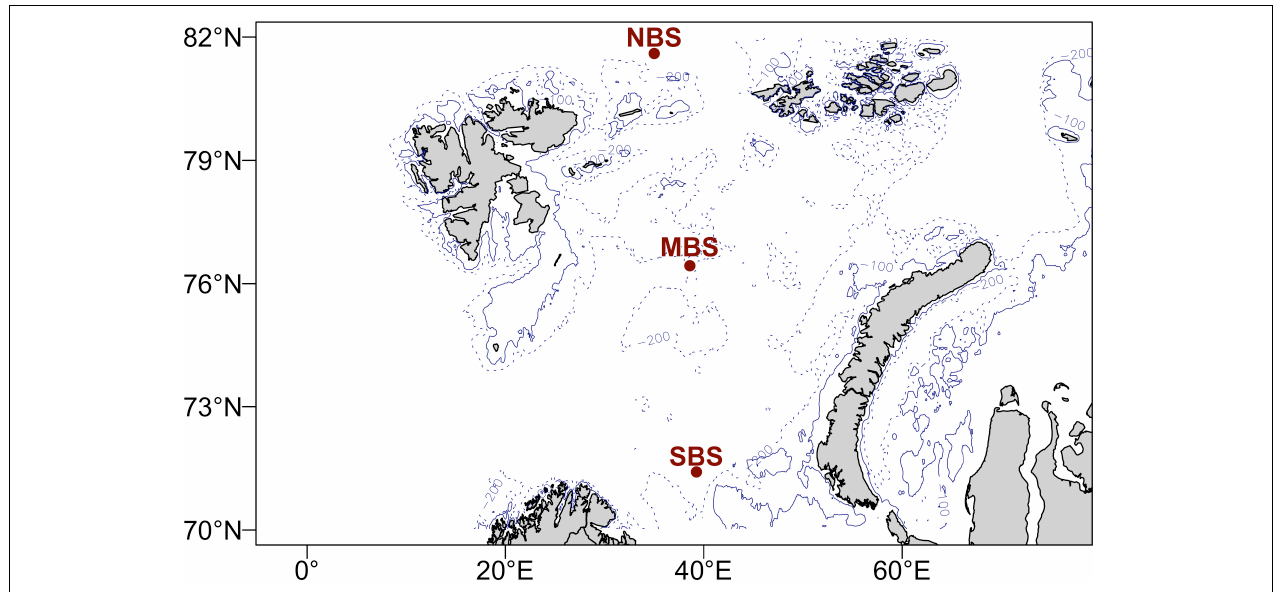
FIGURE 2 | Map of the Barents Sea area. Red dots indicate the three stations where environmental forcing are extracted to run experimental simulation. NBS means north Barents Sea station, MBS means central Barents Sea station, and SBS means south Barents Sea